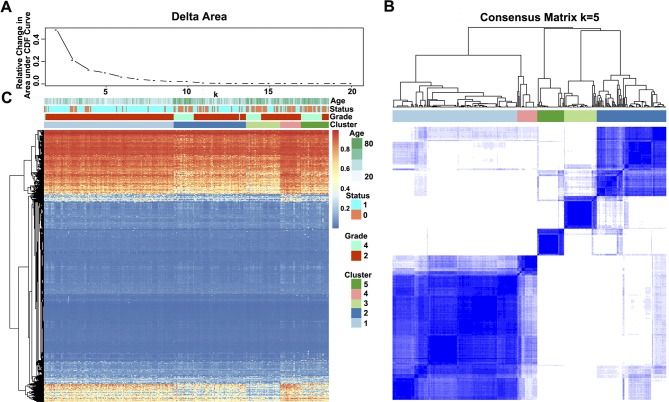
Consensus matrix for DNA methylation classification with the corresponding heat map. (A) Delta area curve of consensus clustering, indicating the relative change in area under the cumulative distribution function (CDF) curve for each category number k compared with k − 1. The horizontal axis represents the category number k, and the vertical axis represents the relative change in area under the CDF curve. (B) Color-coded heat map corresponding to the consensus matrix for k = 5 obtained by applying consensus clustering. The color gradients were from 0 to 1, representing the degree of consensus, with white corresponding to 0 and dark blue to 1. (C) Heat map corresponding to the dendrogram in (B), which was generated using the pheatmap function with DNA methylation classification, tumor stage, age, and prognostic status as the annotations.